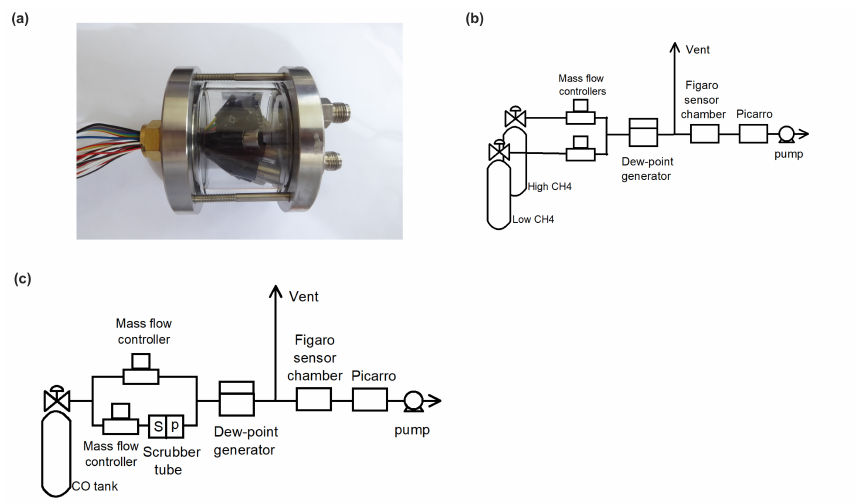
Figure 1. ( a ) Picture showing the sealed chamber with six Figaro ® sensors of different types, and temperature and pressure sensors. ( b ) Scheme of the CH 4 and H 2 O cross-sensitivity measurement set up. ( c ) Scheme of the CO and H 2 O cross-sensitivity measurement set